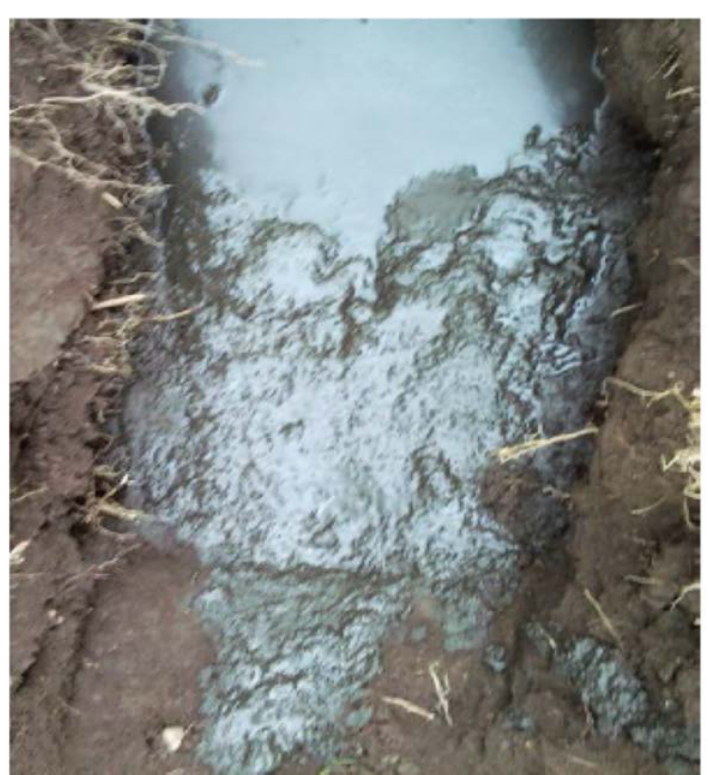
Figure 18. Substrate T0 [9].